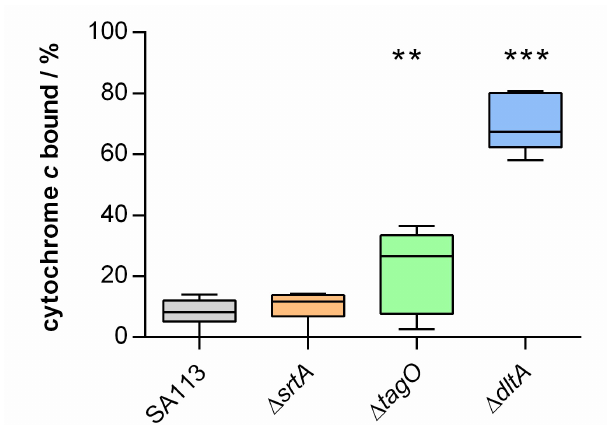
Figure 2. Surface charge of SA113 and its knock-out mutants. Binding capacities of the cationic protein cytochrome c by SA113 and its knock-out mutants. Data are presented as box and whisker plot (min-to-max) obtained from six to eight independent experiments. Comparison between data sets was conducted by ordinary one-way ANOVA and Dunnett’s test for multiple comparison: **, p < 0.01; ***, p < 0.001.